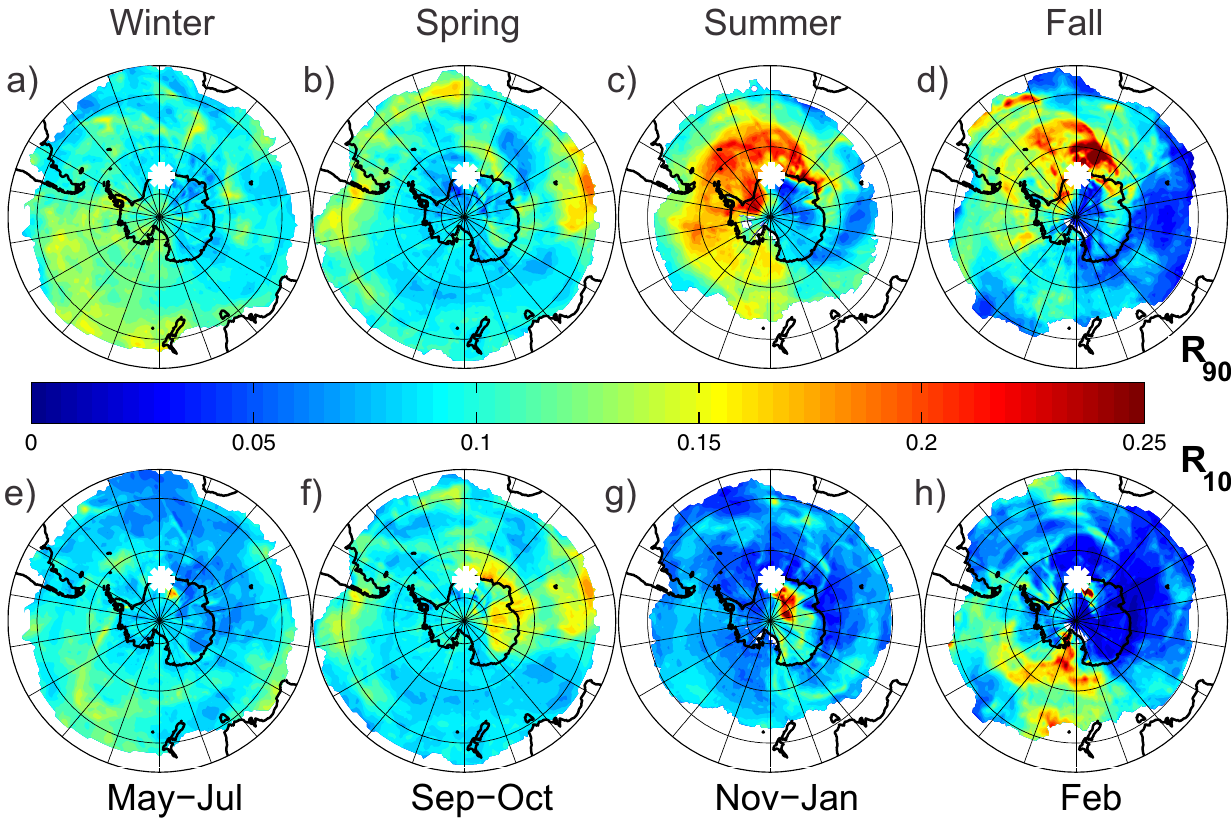
Fig. 5. Fields of R 90 (top four panels) and R 10 (bottom four panels) for GEM measurements at TRS from 2007 through June 2010. The Figure 5. Fields of R location of TRS is marked with a white asterisk. Areas where S T is below the threshold are plotted at TRS from 2007 through June 2010. The location of TRS is marked with a white asterisk. 4 Areas where S